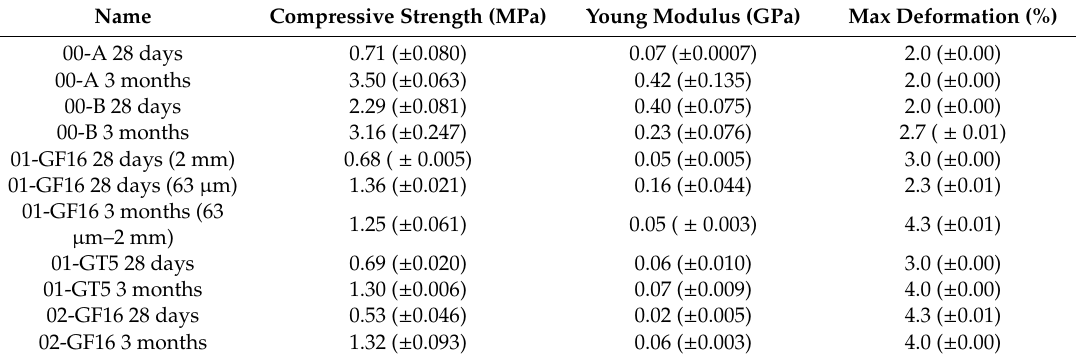
Table 8. Compressive strength, Young modulus and Max Deformation for mortars with thermally treated soil from Gavdos (GF16 and GT5) and commercial pozzolanic additives (A and B).